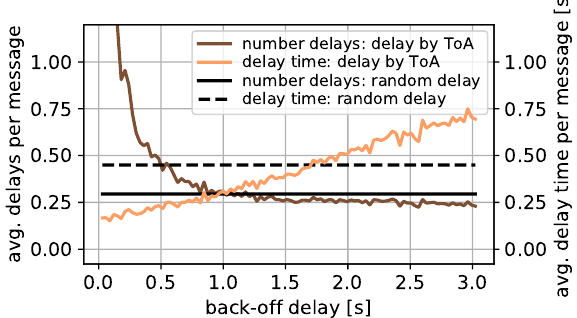
Figure 5. Optimal back-off